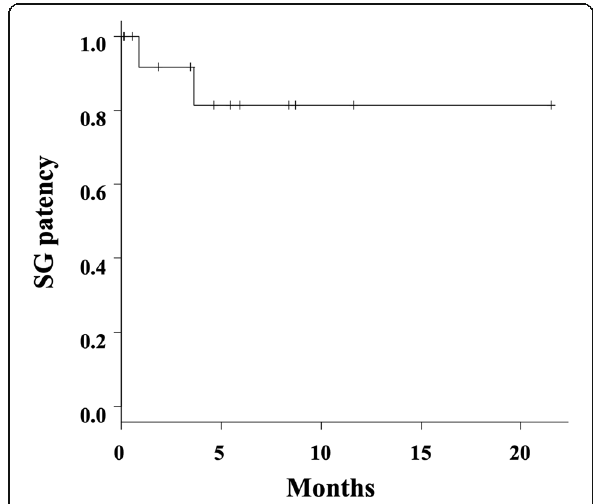
Fig. 3 Stent graft patency. A Kaplan – Meier curve reveals stent graft patency over time for the Viabahn stent grafts. The transverse axis shows the time (months) after the procedure. SG, stent